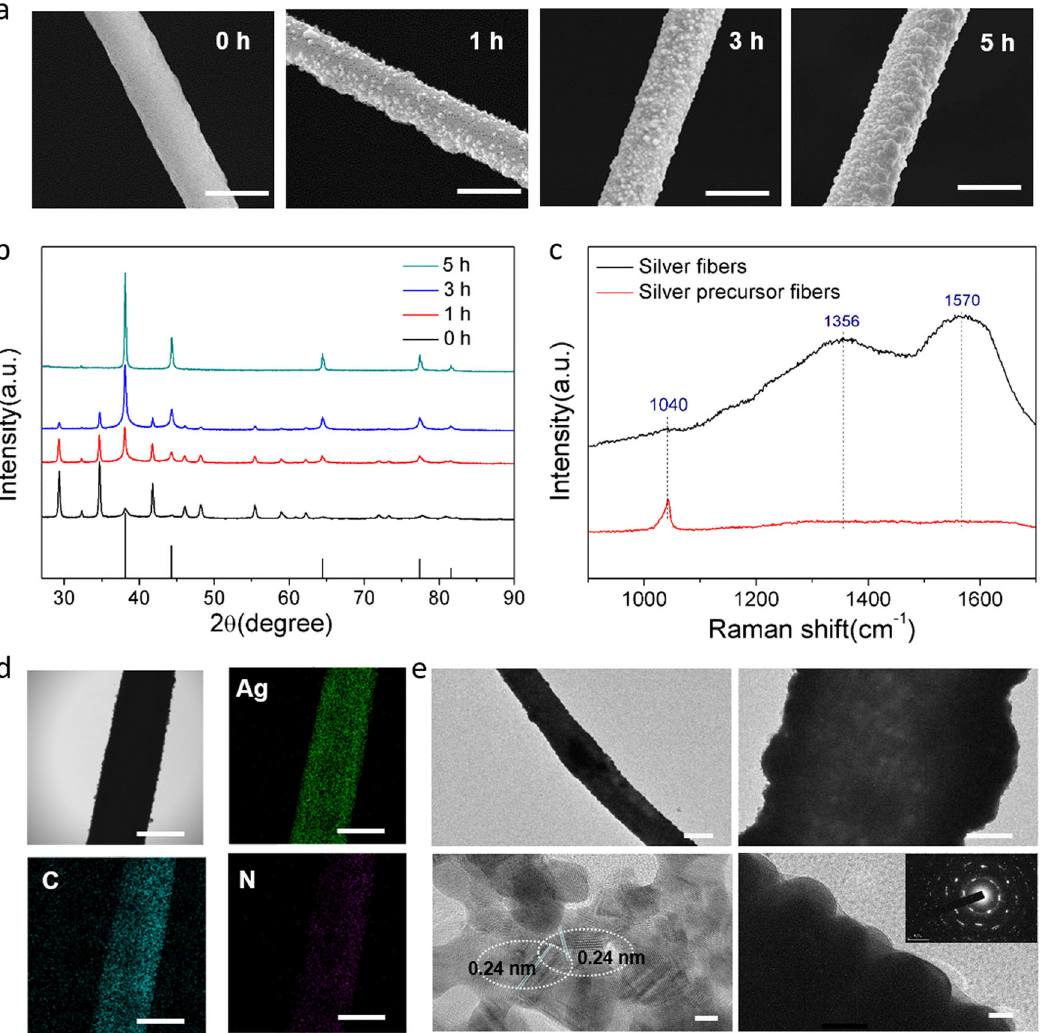
Fig. 2 Reaction process and reaction mechanism of silver precursor fi bers turn into the silver fi bers. a SEM images of the single fi ber after different UV irradiation time (scale bar: 1 μ m). b The XRD patterns of silver fi bers in different UV irradiation time. c The Raman spectrums of silver precursor fi bers and the silver fi bers (UV irradiation for 5 h). d Element scanning images of the silver fi bers (scale bar: 500 nm). e TEM image of single silver fi ber (scale bar: 0.5, 0.2 µm, 5, 20 embedded image. Supplementary Figure S4 provides the Auger electron spectroscopy pattern of silver submicron fi bers, wherein the different curves represent the composition of the samples corresponding to different depths from the fi ber surface (from top: 0, 90, 180, 360 nm), which testi fi ed the presence of polymer skeleton in silver fi ber.